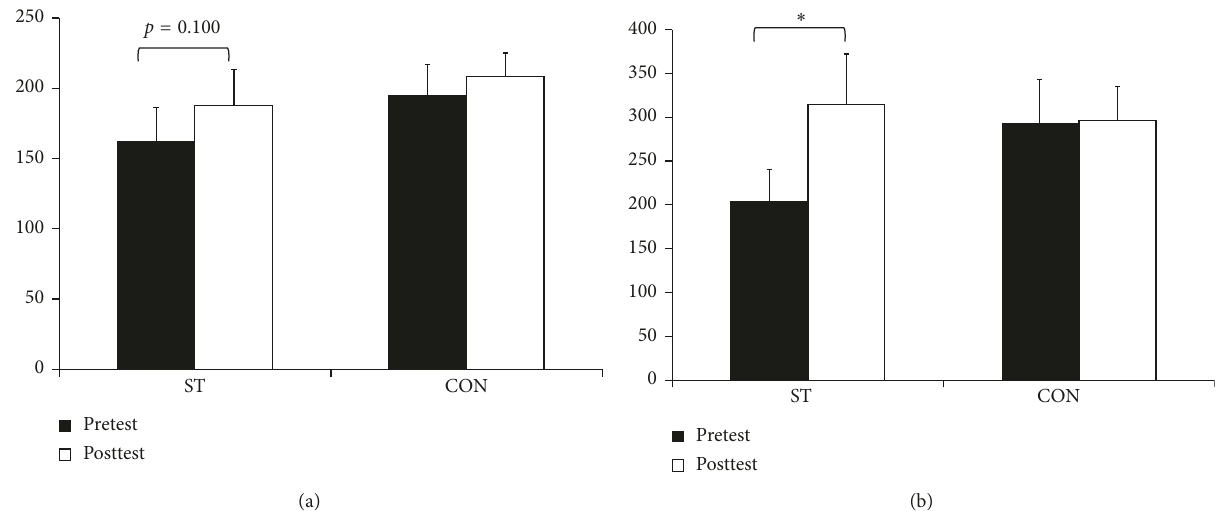
Figure 3: The pre- and posttest results of the (a) maximal strength and (b) RFD in leg extension for the strength-training group (ST) and control group (CON). All values are presented as mean ± SE. ∗ Within-group differences, p < 0 . 05.